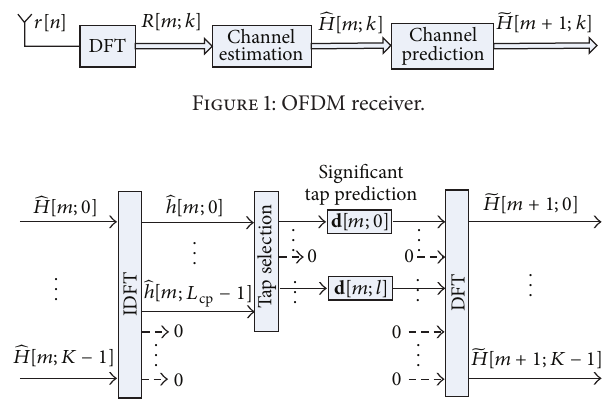
Figure 2: Time domain predictor for sparse